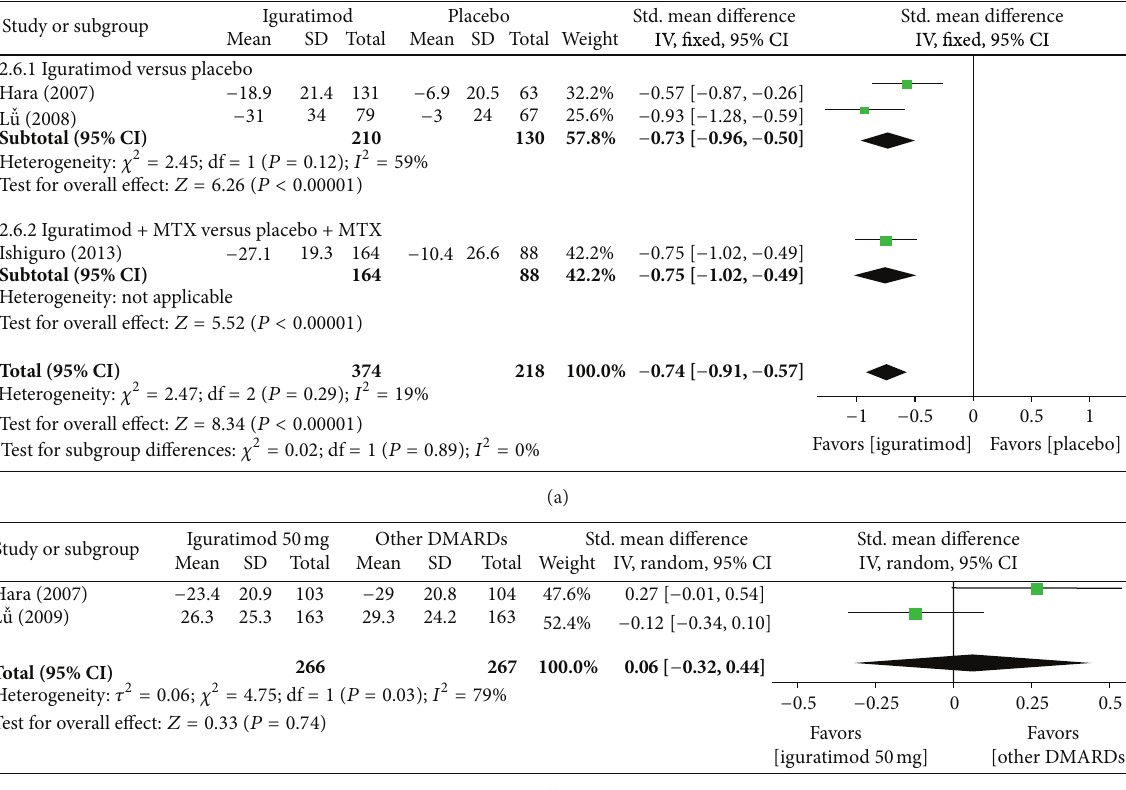
Figure 8: (a) Comparison of physician global assessment of disease activity between iguratimod and placebo groups. (b) Comparison of physician global assessment of disease activity between iguratimod and other DMARDs (MTX and SASP) groups.